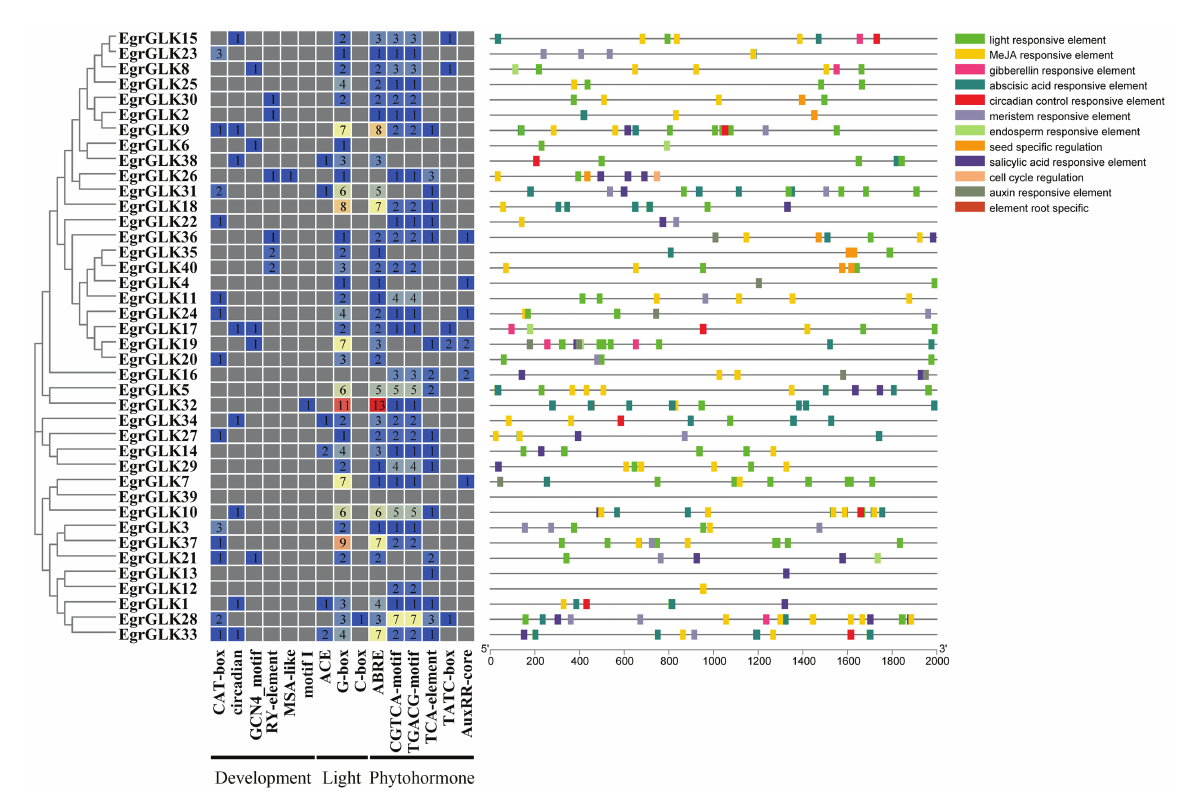
FIGURE 5 Analysis of cis -acting regulatory element in promoter regions of EgrGLK genes of E. grandis . Numerals in different color boxes indicate the number of the main cis -elements of EgrGLK genes. Cis -elements of different responsive types are indicated by different